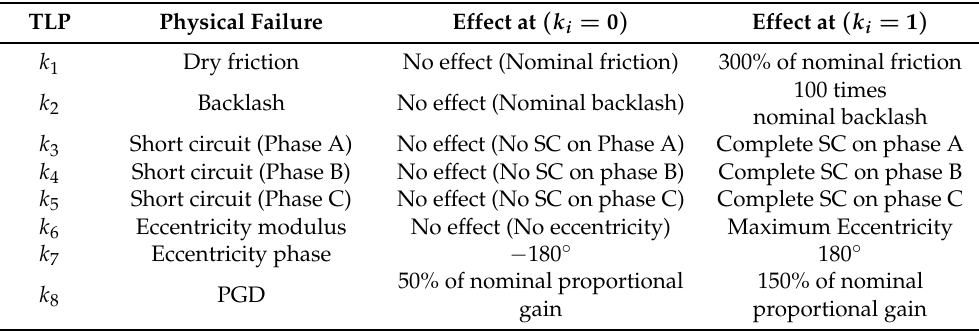
Table 1. Top level parameters meaning and effects. TLP Physical Failure Effect at ( k i = 0 ) Effect at ( k i = 1